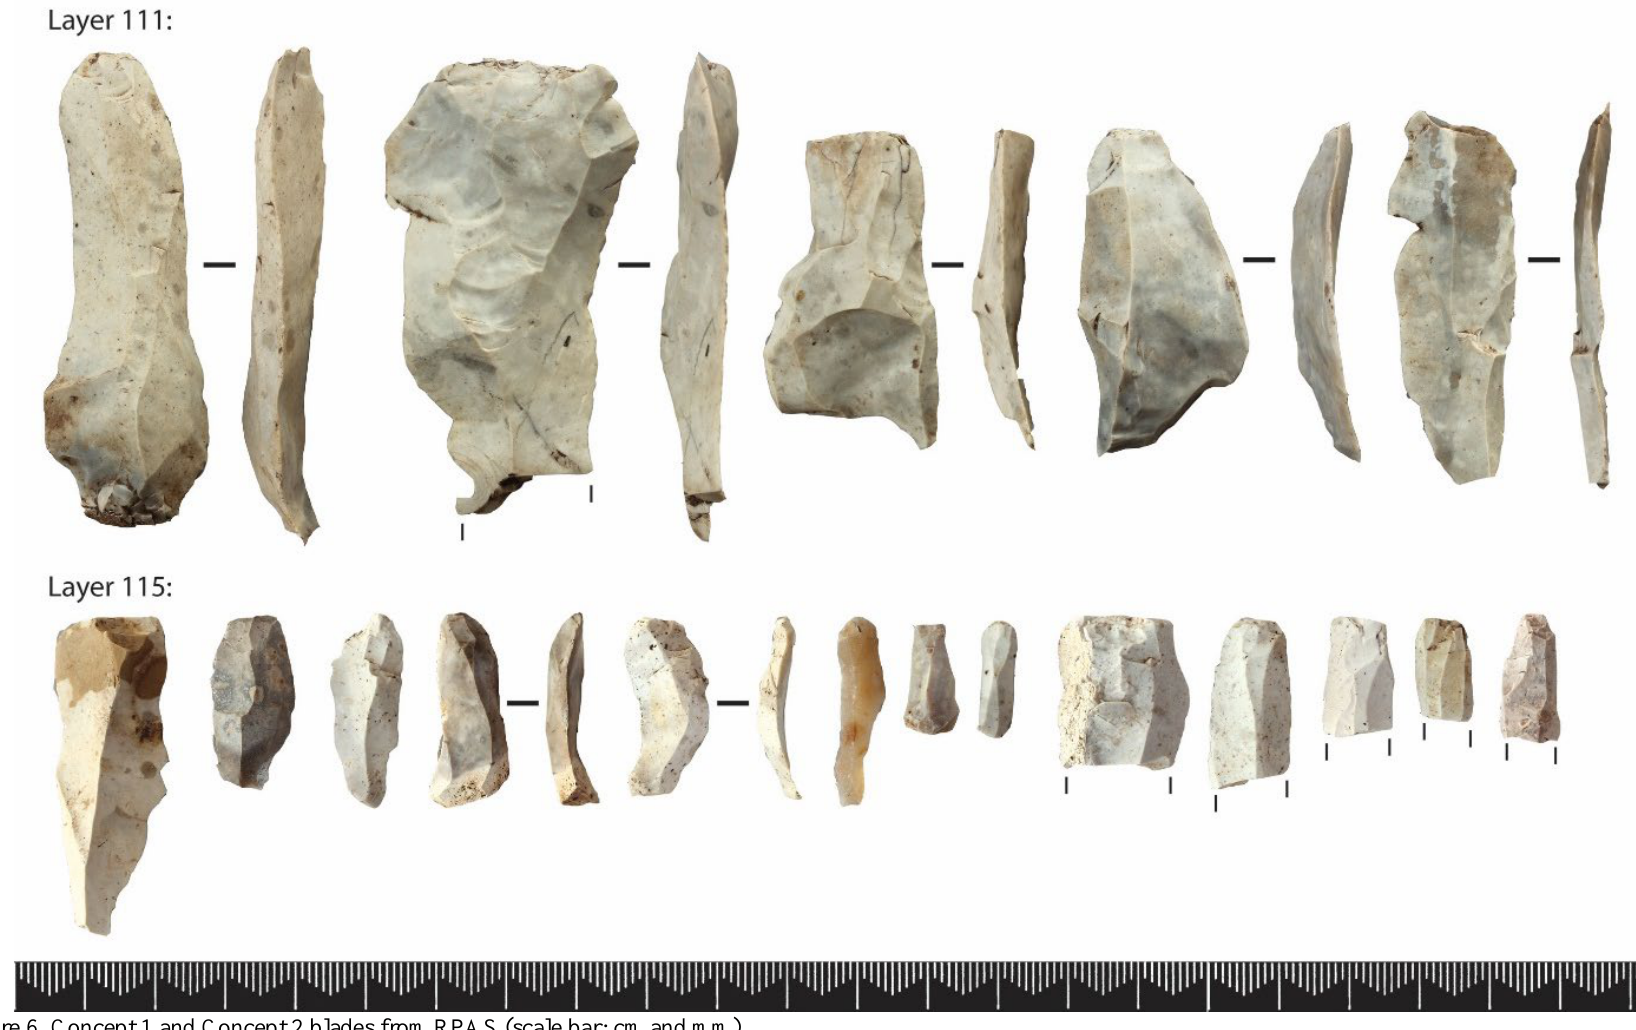
Journal of Lithic Studies (2019) vol. 6, nr. 1, p. xx-xx DOI: https://doi.org/10.2218/jls.2892